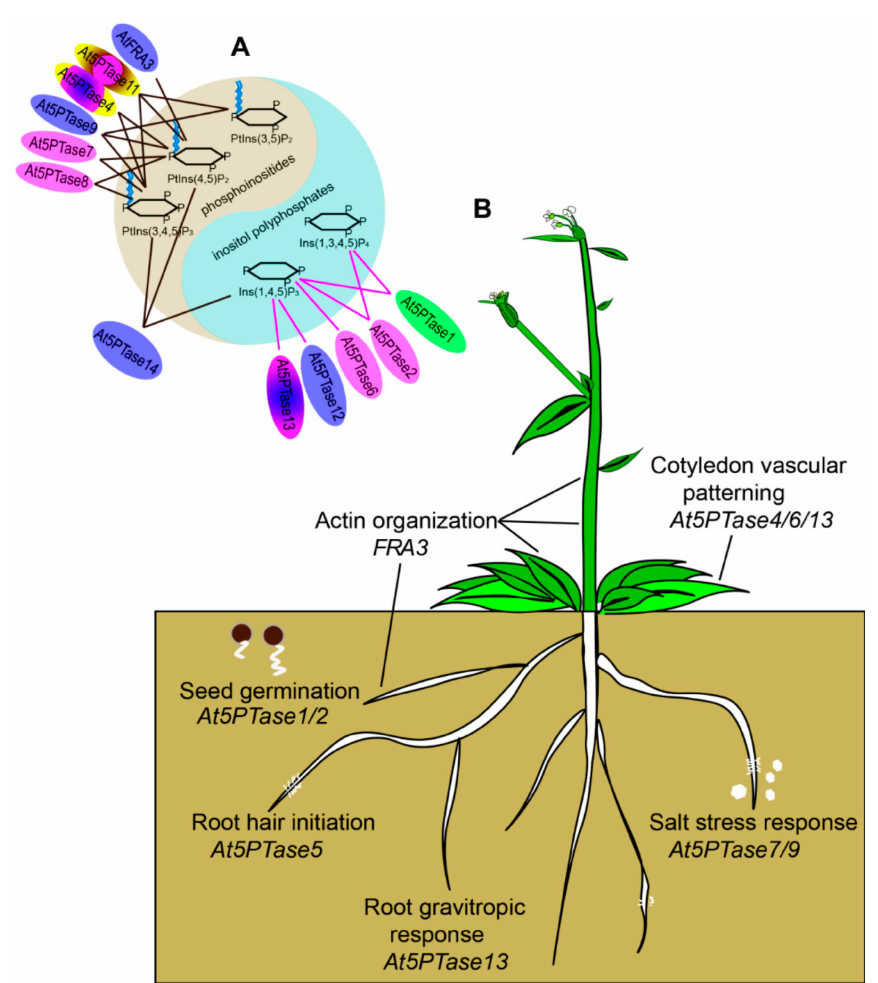
Figure 8. Functionally characterized 5PTase genes from Arabidopsis . ( A ) Substrate specificity and protein localization of At5PTases. FRA3, 5PTase9, 5PTase12, and 5PTase14 were localized in the nucleus; 5PTase2, 5PTase6, 5PTase7, and 5PTase8 were localized in the cytoplasm; 5PTase1 was localized in chloroplasts; 5PTase13 was localized in the nucleus and cytoplasm; 5PTase11 was localized in the